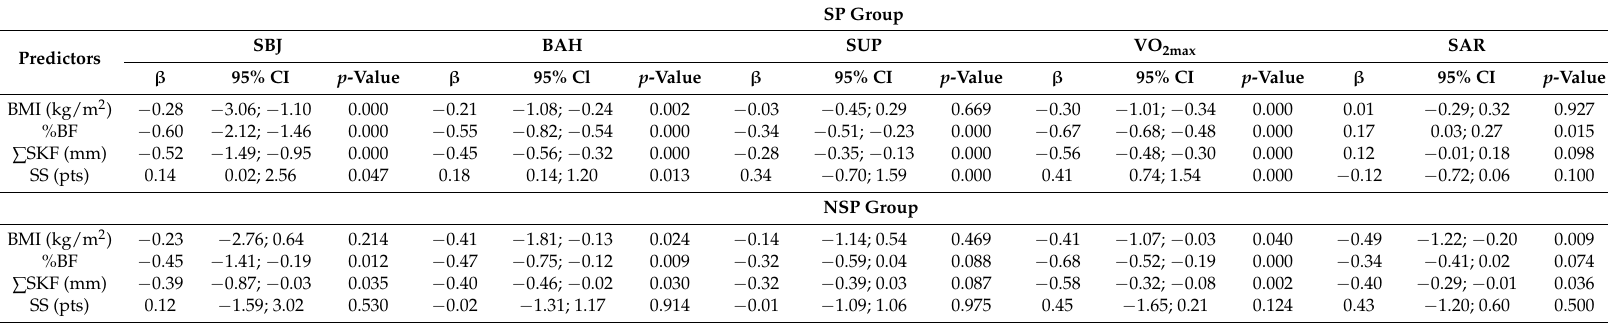
Table 4. Simple linear regression coefficient ( β ), 95% CI and p-values for associations between physical fitness measures and prediction variables. SP